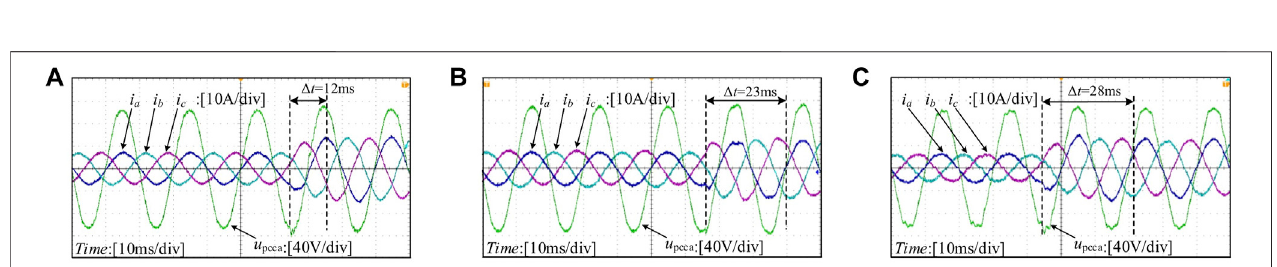
FIGURE 12 | Dynamic experimental results of the inverter at L g (cid:1) 1.5 mH: (A) with the proposed method in this paper, (B) with the method in Liu et al. (2020), and (C) with the method in Jiao and Lee (2015).